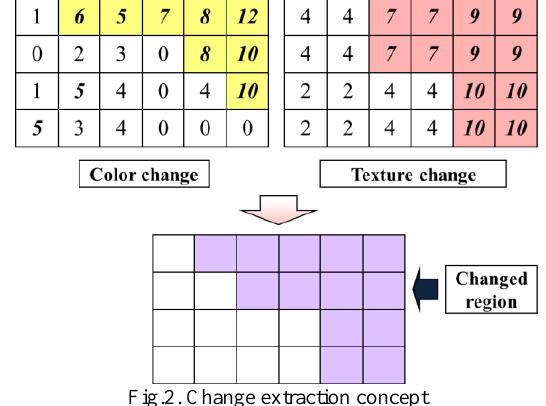
Fig.2. Change extraction concept